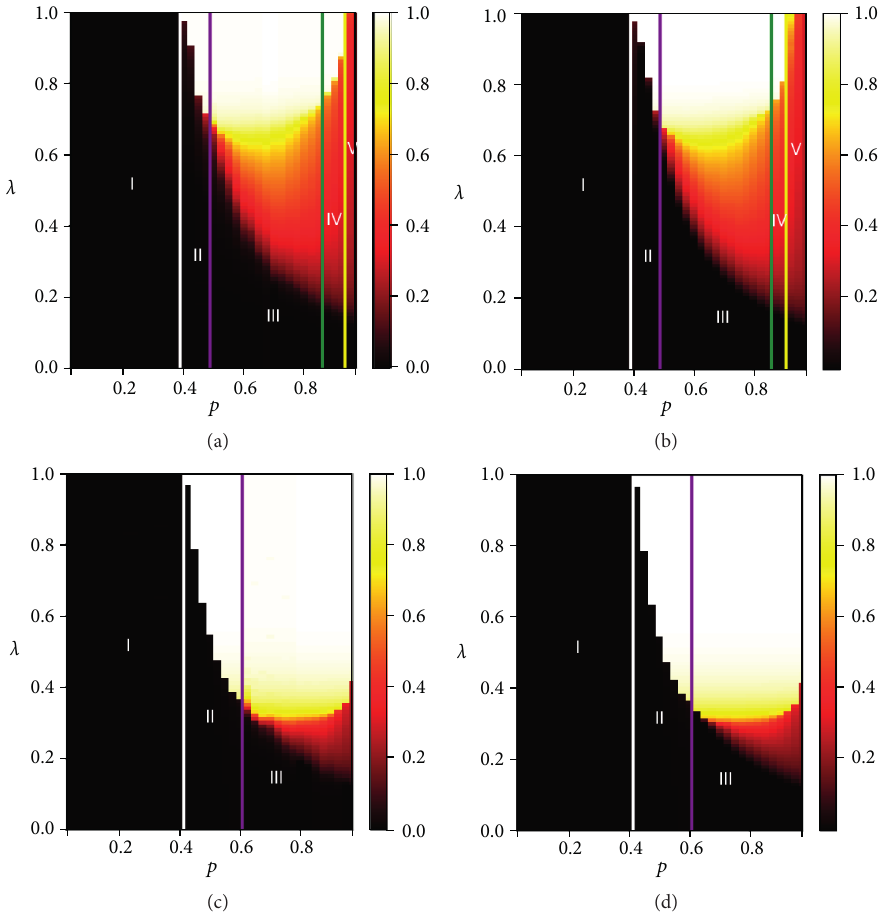
Figure 4: The change of phase transition. Dependence of R ( ∞ ) on (p) and λ at r � 1/5 in (a) and (b) and at r � 3/5 in (c) and (d). The 0 0 color-coded values of final spreading size R ( ∞ ) in the parameter plane ( p, λ ) of (a) and (c) are from simulation results, (b) and (d) are from theoretical predictions. The theoretical predictions are the solutions of equations (12) and (22)–(24). The different phase transition regions are separated by the vertical lines which represent the critical contact probability of homogeneous individuals. Other parameters: N � 10000, ρ � 0.19, I � 5, T � 5, k � k � 10, c � 1, ε ⟶ B A B B 0